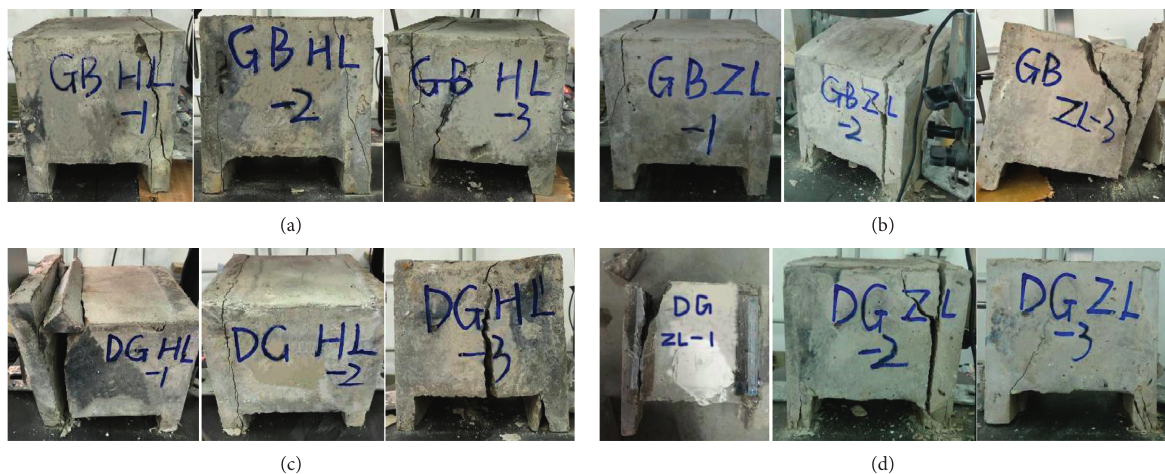
Figure 9: Shear fracture of cement plate and concrete composite specimens with different ribs: (a) GB HL, (b) GBZL, (c) DG HL, and (d) DG ZL.